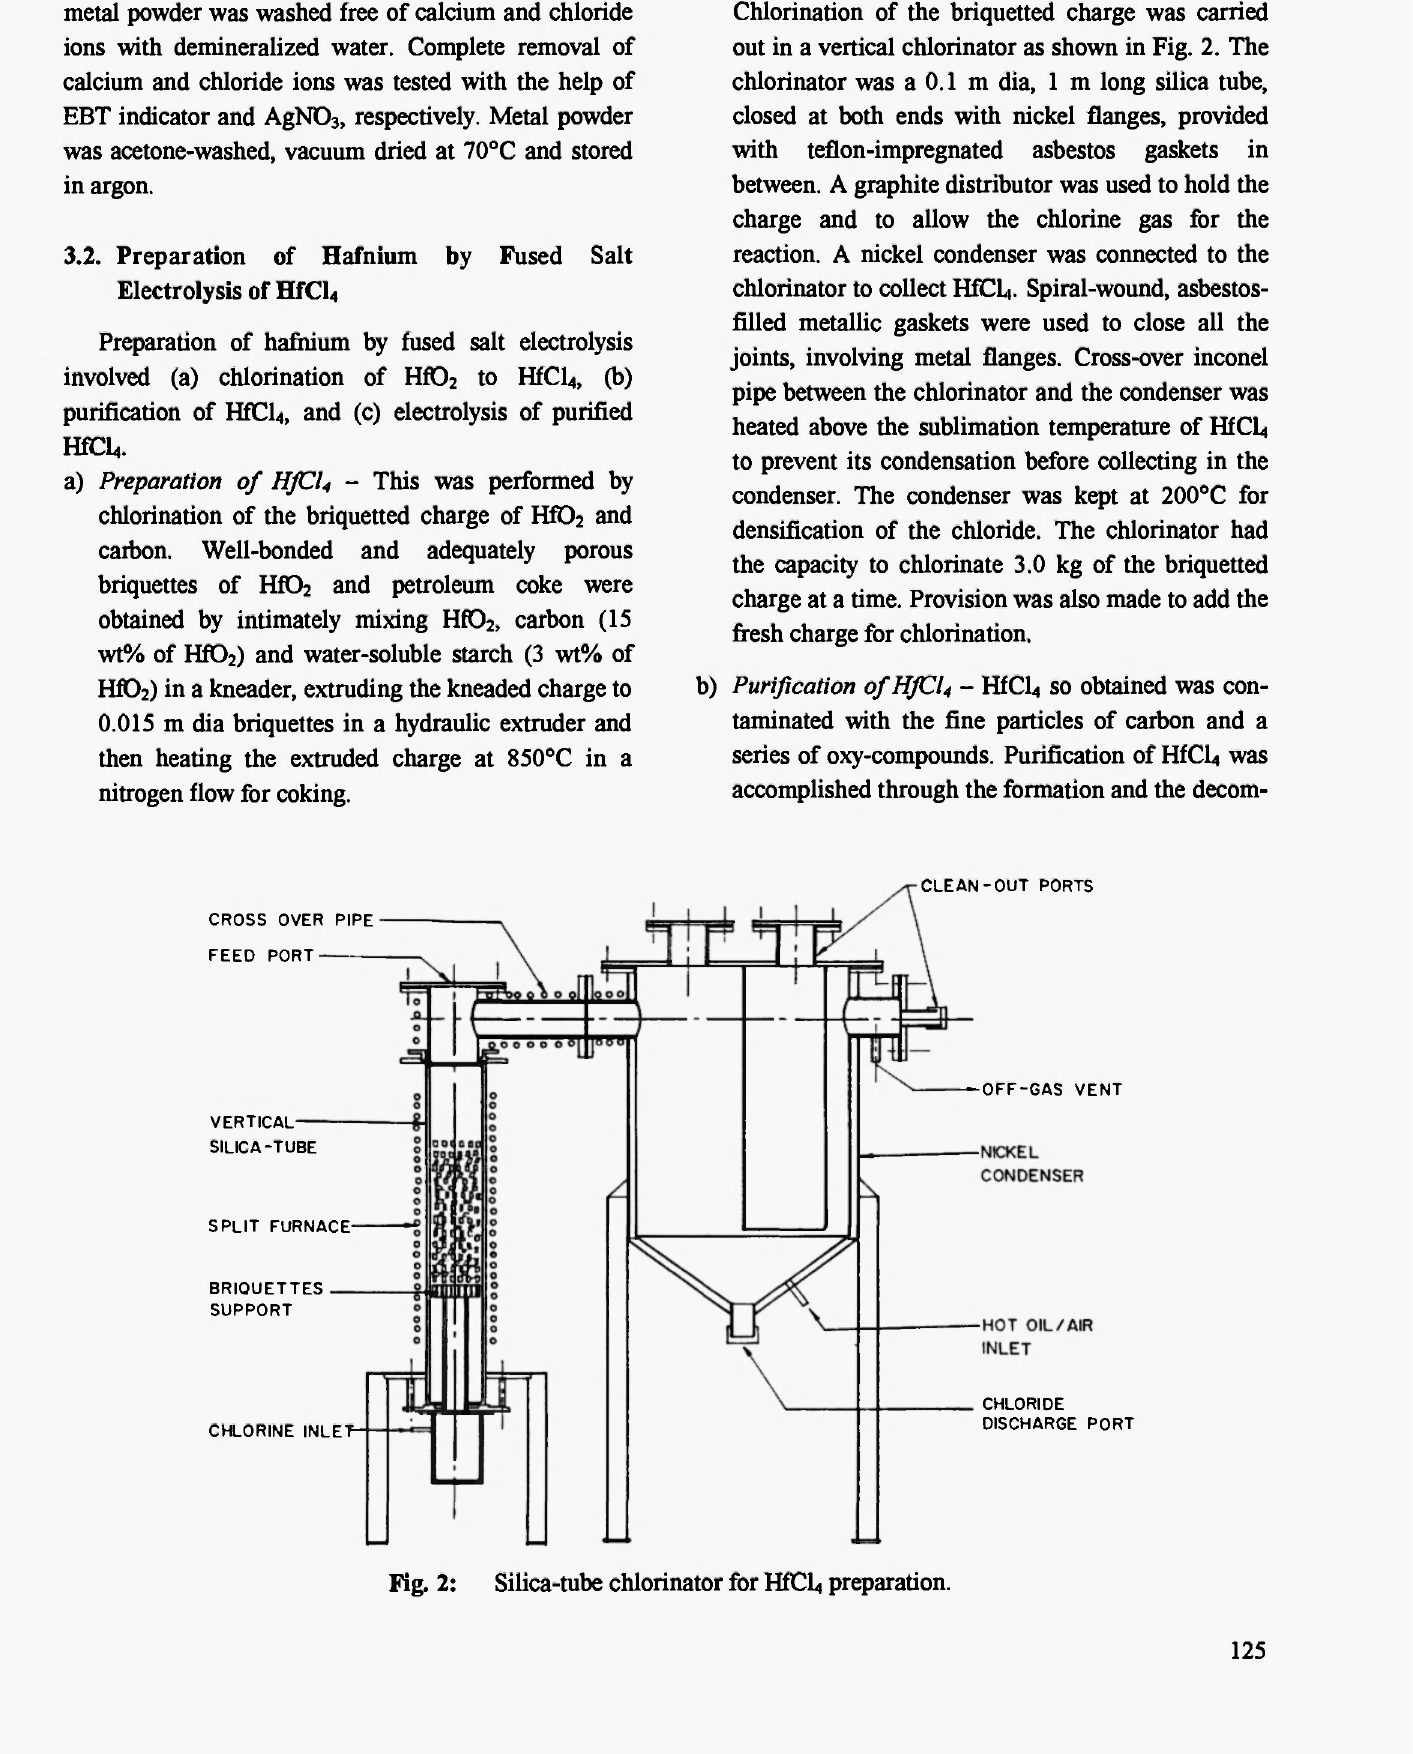
Fig. 2: Silica-tube chlorinator for HfCLt